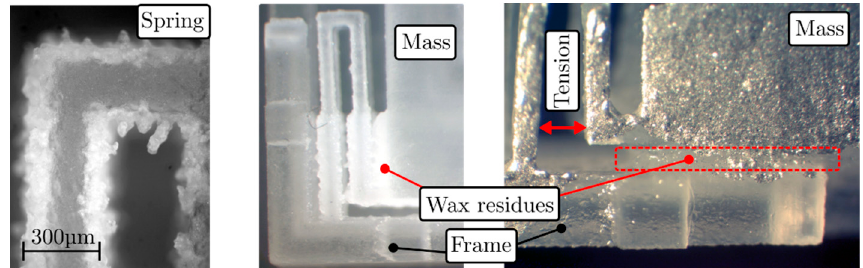
Figure 2. Limitation of 3D printing technology is shown by the very first prototype. Surface roughness occurs at long and thin free standing areas, e.g., springs ( left ). Remaining wax and acrylate residues introduce clumping ( middle ) and tension ( right